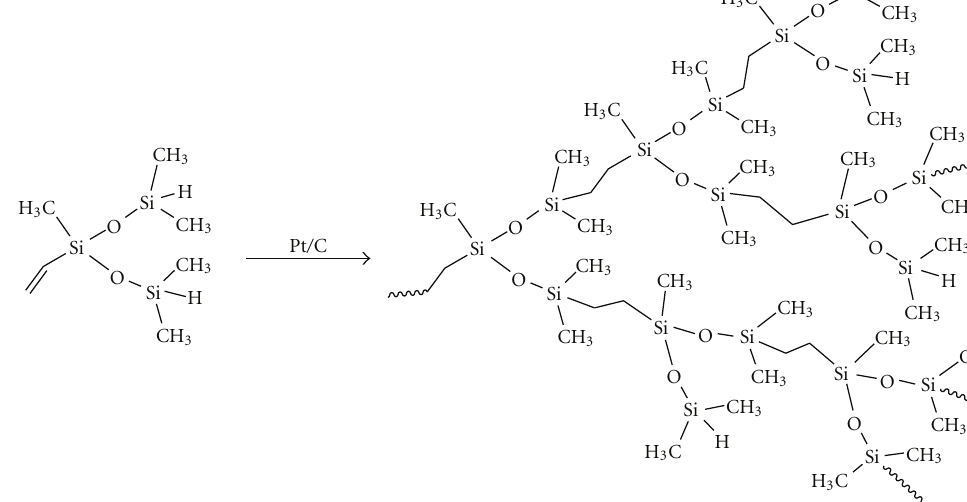
Scheme 2: Synthesis of hyperbranched poly(siloxysilane).